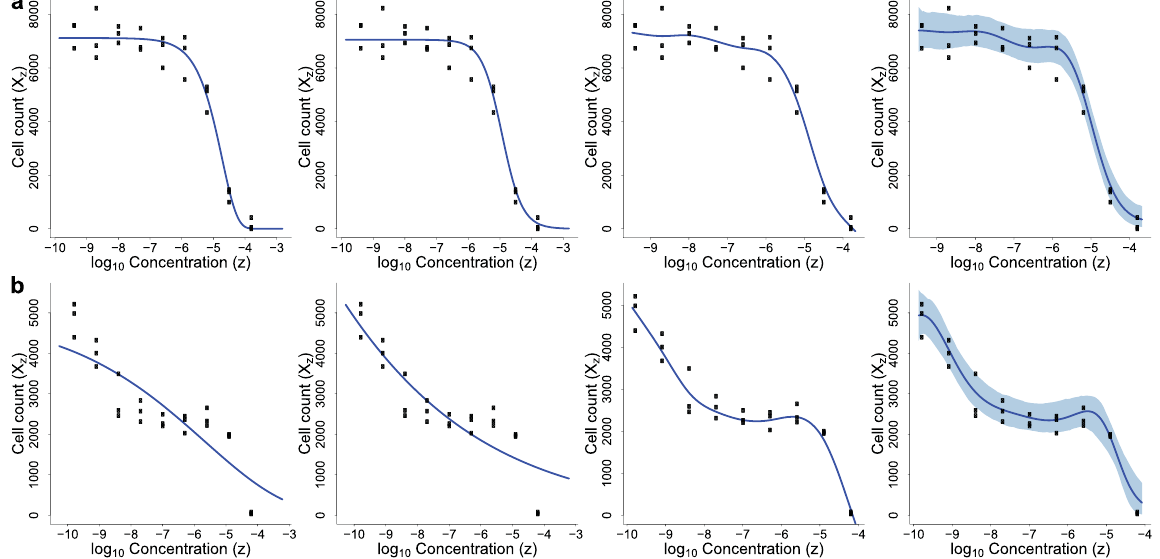
Figure 1. Dose-response modeling of cell line AU565 treated with compound 4-HC ( a ) and cell line SUM52PE treated with compound Everolimus ( b ), using Gompertz curve fitting (the first panel), logistic curve fitting (the second panel), grofit (the third panel) and bdChemo (the fourth panel). Solid circles and blue curves are data points and fitted curves, respectively. For bdChemo, curves and shades represent the posterior mean and the 95% credible interval of the Kendall Process mean,